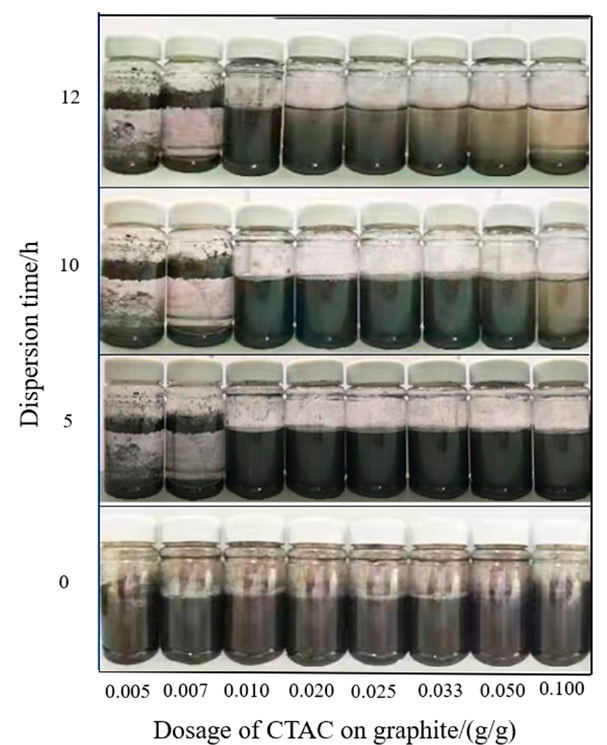
Figure 1. The effect of CTAC dosage on the dispersibility of graphite. Table 2. Graphite sedimentation experiment.